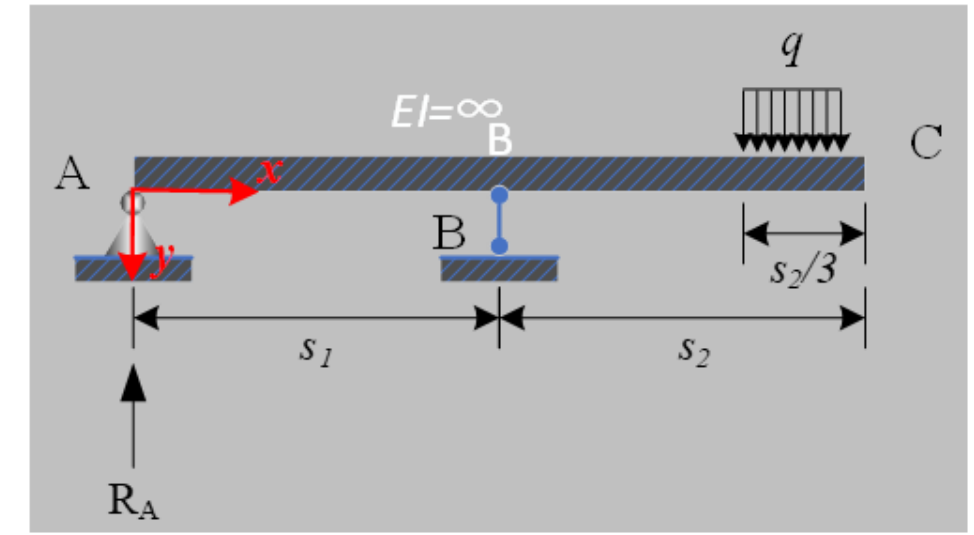
Figure 2. The equivalent overhanging beam model for the seesaw.